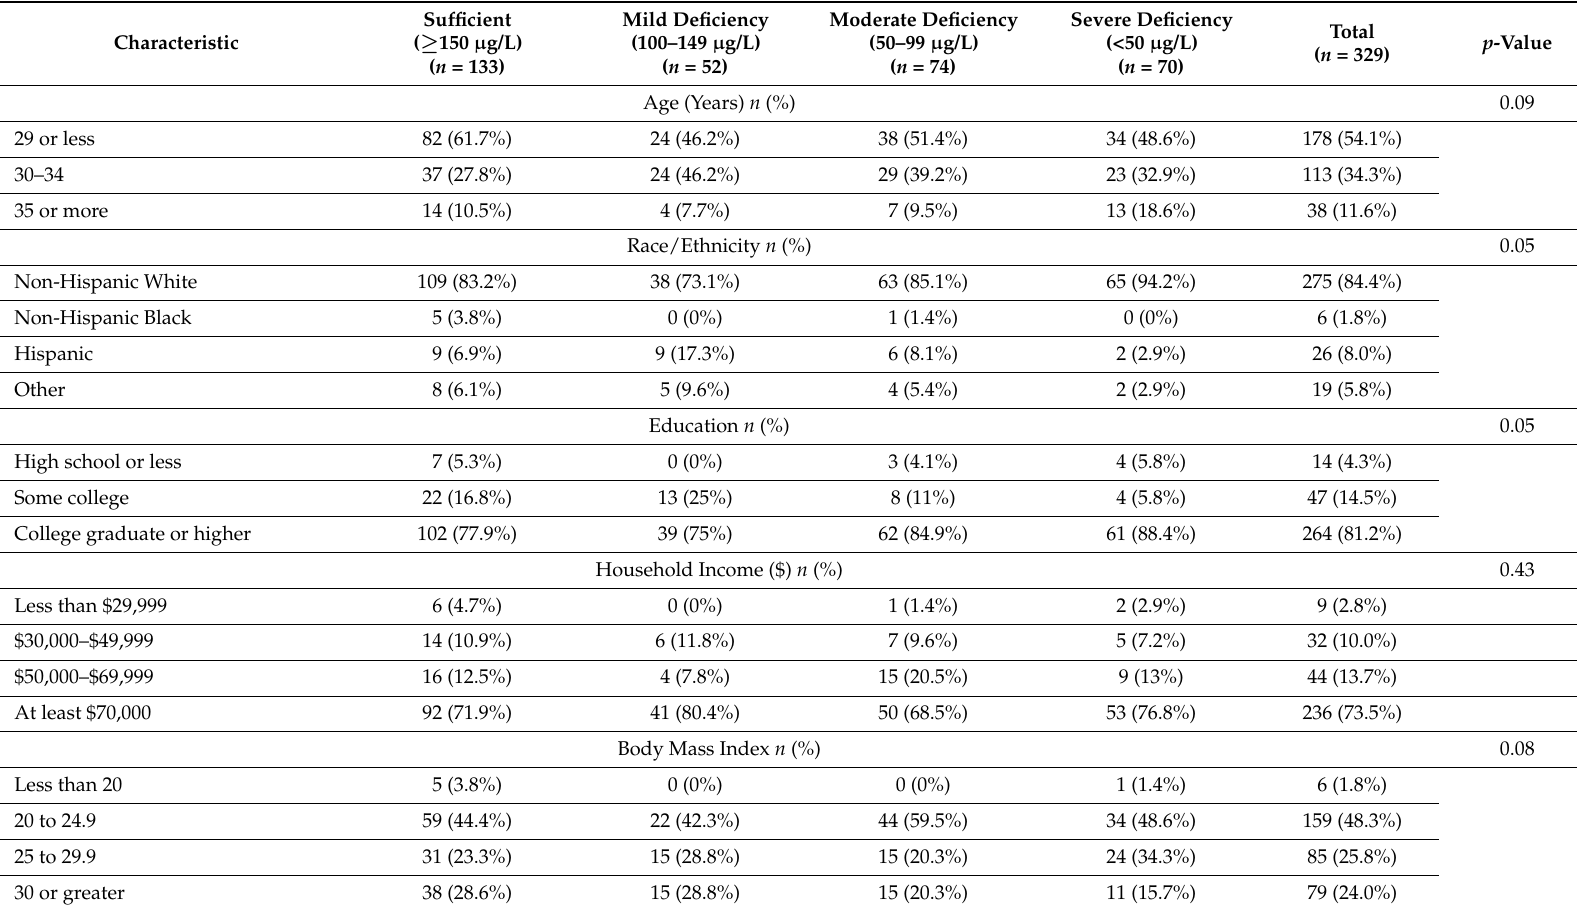
Table 2. Medical and socio-demographic factors of women becoming pregnant by World Health Organization categories of urinary iodine concentration ( µ g/L) ( n =